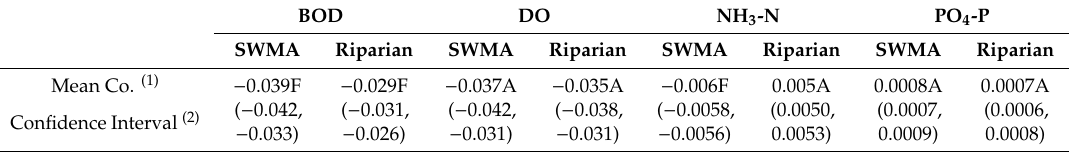
Table 5. Mean coe ffi cients and confidence intervals of coe ffi cients in estimated GWR models. BOD